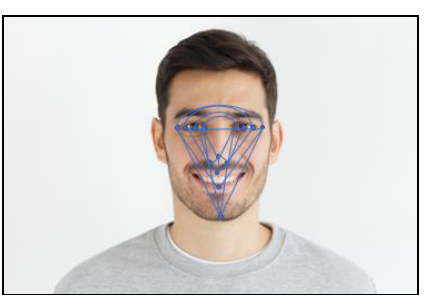
Figure 1. FGNet annotation [12].